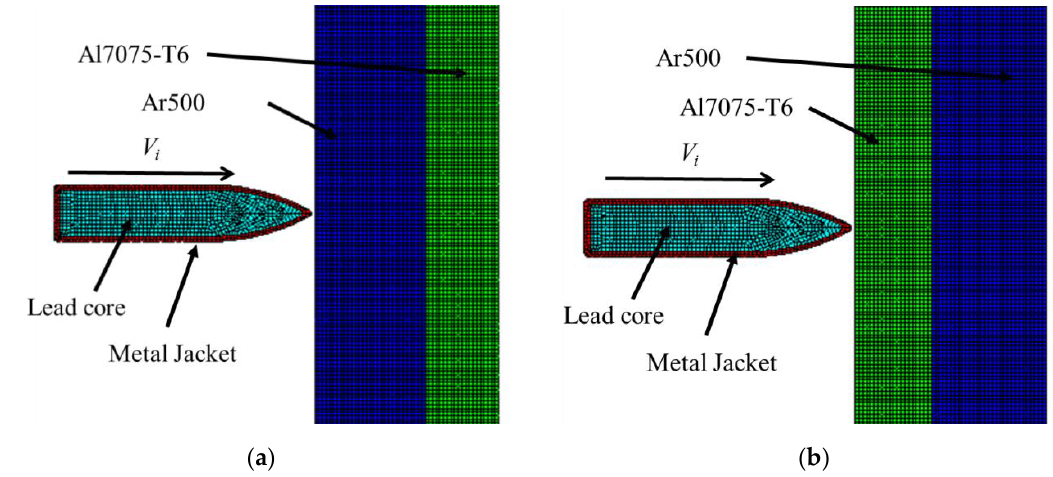
Figure 5 . FEA model of 7.62-mm FMJ projectile and double-layered target plate for: ( a ) Configuration A; and ( b ) Configuration B.